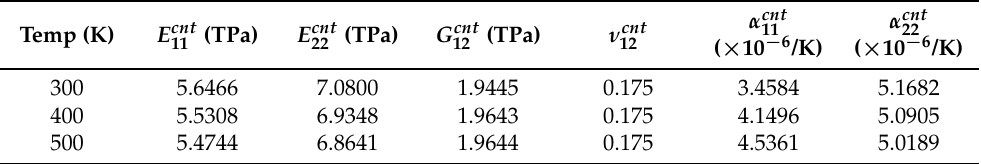
Table 2. The material properties of (10, 10) SWCNTs (tube radius = 0.68 nm, thickness = 0.067 nm, length = 9.26 nm, ν cnt = 0.175) 12